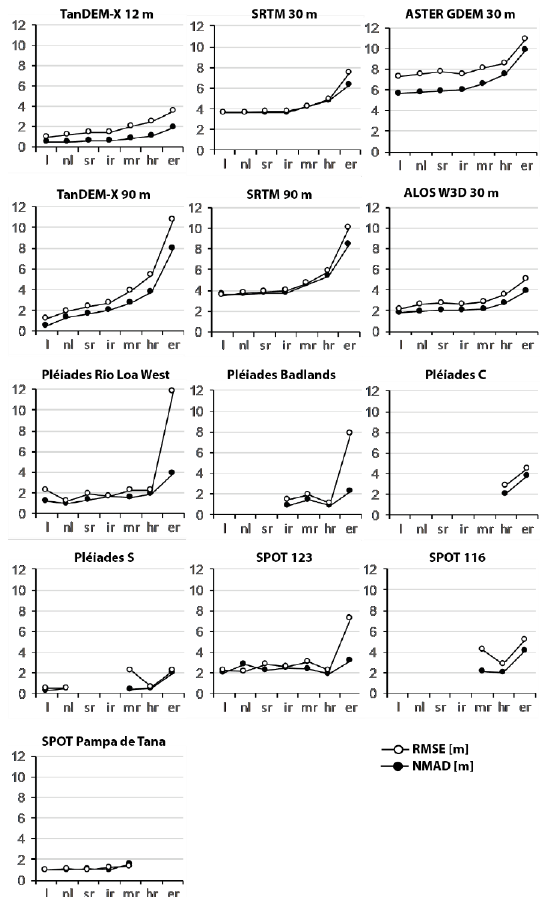
Figure 2. Calculated RMSE of elevation differences according to the classified Topographic Roughness Index from level to